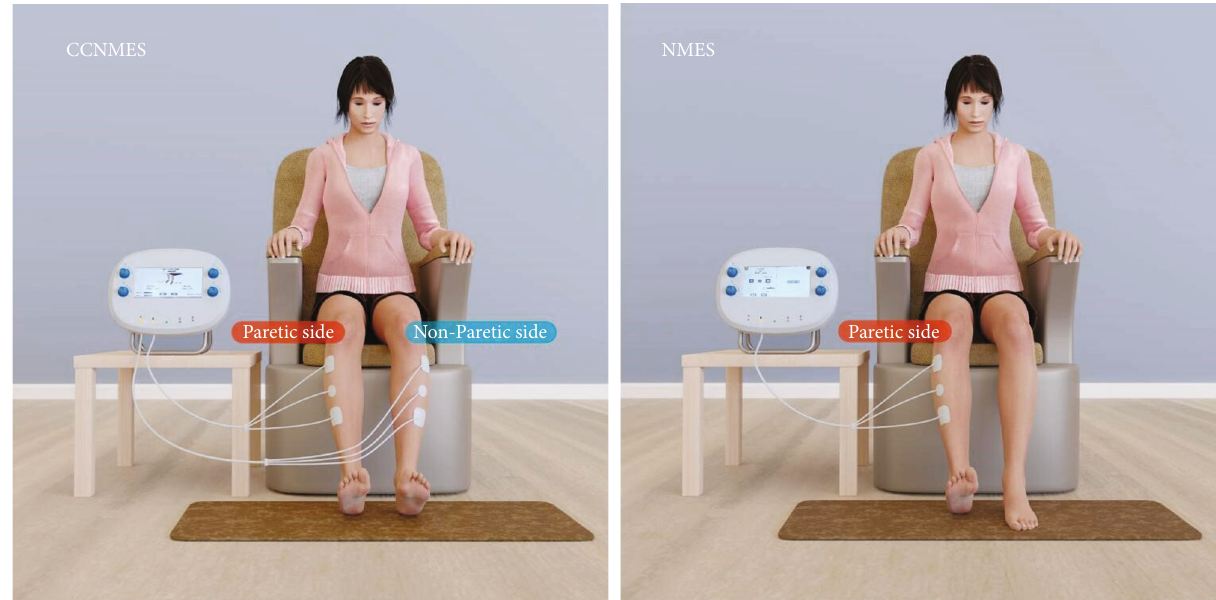
Figure 1: Graphical presentation of contralaterally controlled neuromuscular electrical stimulation (CCNMES) and neuromuscular electrical stimulation